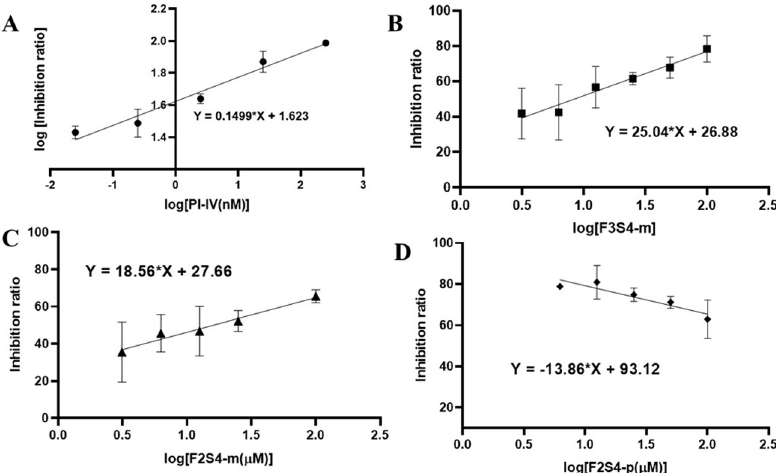
Fig 5. Inhibition of the BACE1 enzyme by: (A) known inhibitor IV, (B) F3S4-m , (C) F2S4-m and (D) F2S4-p . The standard error was calculated from the fluorescence measurements of the duplicate of two independent assays with n = 3.